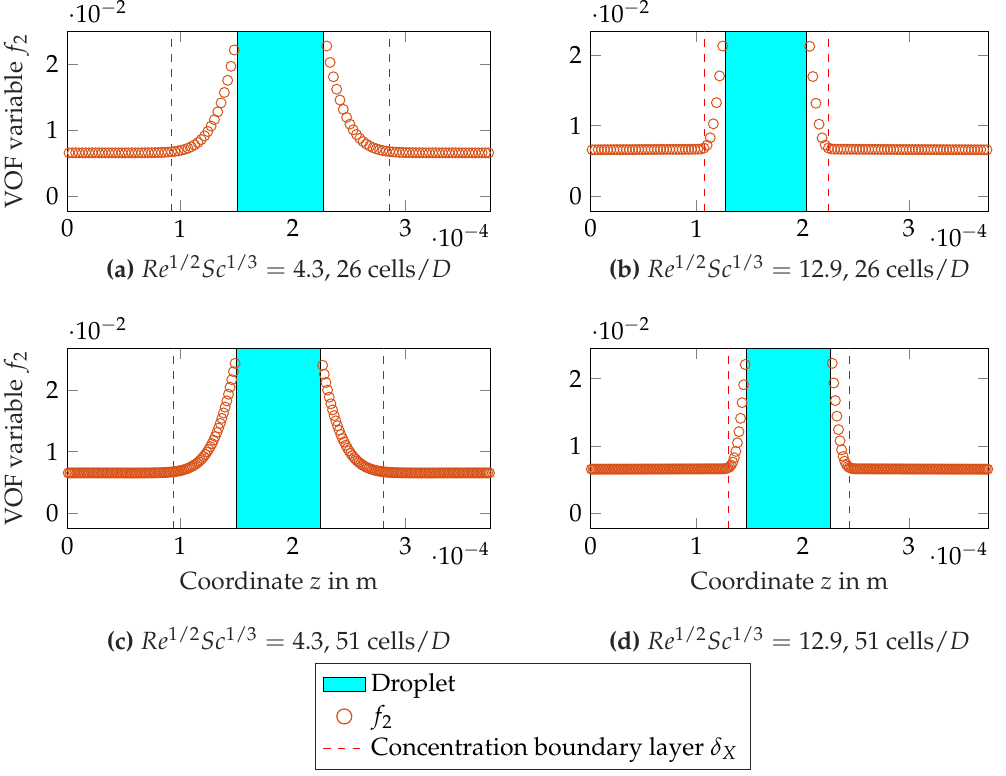
Figure 12. Line plot of volume of fluid (VOF) variable f 2 at constant x , y -position through droplet center, showing the thickness of the concentration boundary layer δ X for different velocities and resolutions. The red dashed line shows the position of the concentration boundary layer δ X . ( a ) δ X = 5.56 × 10 − 6